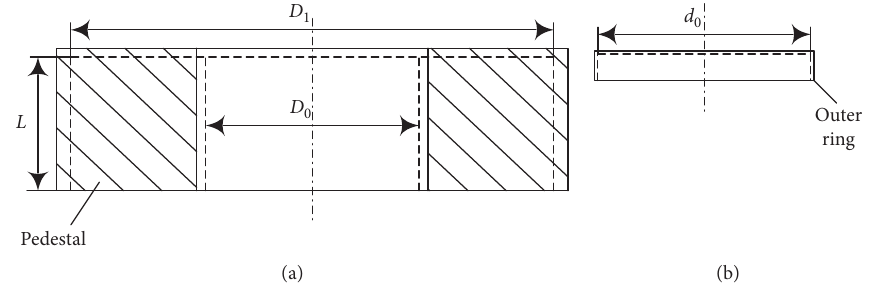
Figure 1: Thermal deformation. (a) The pedestal. (b) The outer ring.